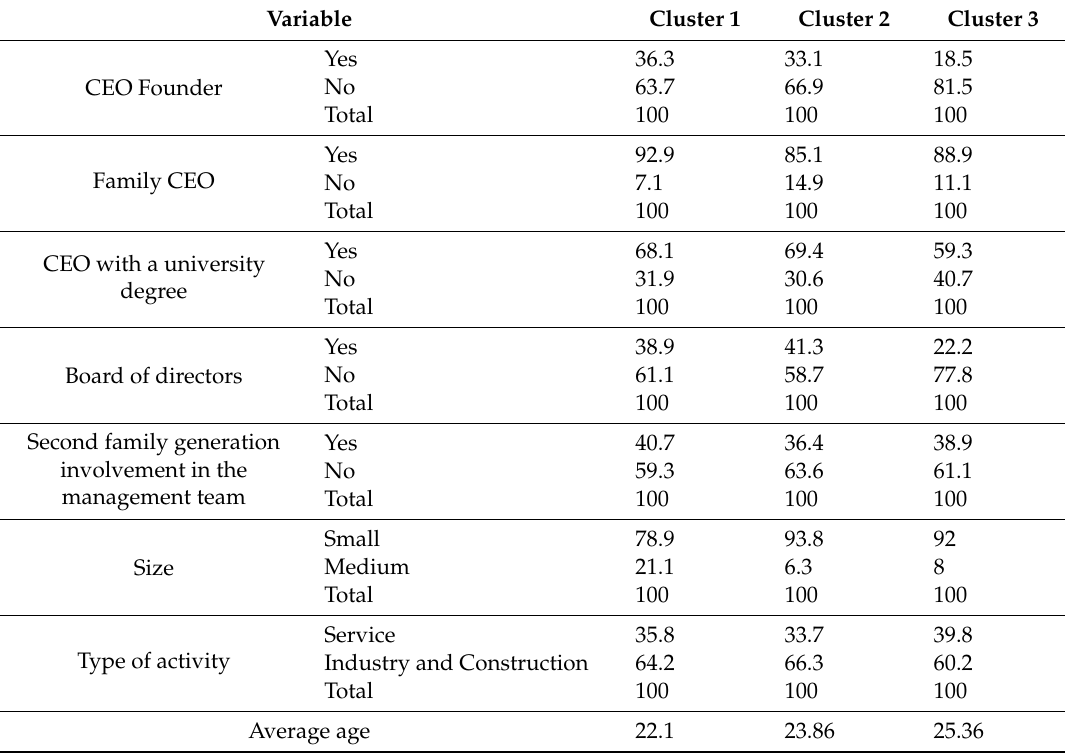
Table 5. Cluster